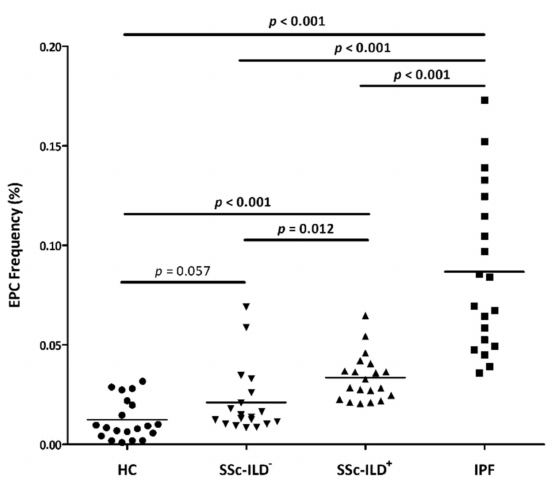
Figure 1. Quantification of EPC population by flow cytometry in all individuals included in the study. EPC were considered as CD34 + , CD45 low , CD309 + , and CD133 + cells in the lymphocyte gate and are expressed as the percentage of cells in this gate. Differences between the study groups were evaluated by Student’s t -test. p -values <0.05 were considered as statistically significant. Horizontal bars indicate the mean value of each study group. EPC: endothelial progenitor cells; HC: healthy controls; SSc: systemic sclerosis; ILD: interstitial lung disease; IPF: idiopathic pulmonary